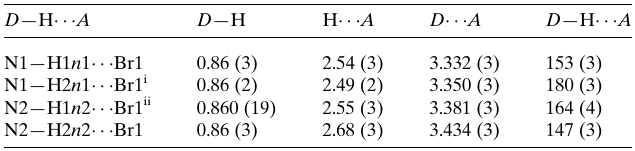
Table 1 Hydrogen-bond geometry (A˚ , (cid:5) ).